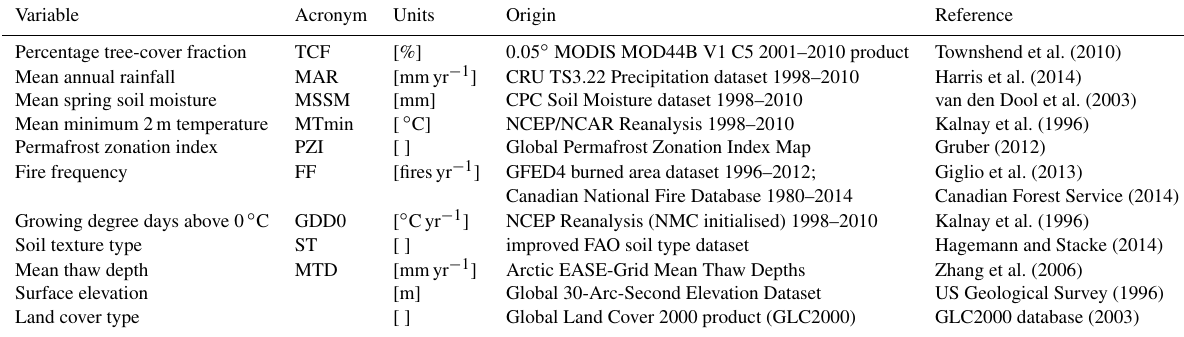
Table 1. Variables and datasets summary. Percentage tree-cover fraction indicates the proportion of land per grid cell covered by trees. Mean annual rainfall corresponds to the mean cumulative precipitation in millimetres over a year. Soil moisture is measured as water height equivalents in a 1 . 6m soil column. Minimum temperature refers to air temperature at 2m height. Permafrost zonation index shows the probability of a grid cell to have permafrost existing only in the most favourable conditions or nearly everywhere. Fire frequency is the averaged number of fire events per year. Growing degree days above 0 ◦ C correspond to the sum of the mean daily temperatures at 2m height above 0 ◦ C through a year, using 6h measurements. Soil texture describes the type of particles forming soil, ranging from sand to clay depending on the particle size. Mean thaw depth corresponds to millimetres of thawing soil during non-freezing days averaged per year. Surface elevation refers to the topographic altitude per grid cell in metres. Land cover type describes the type of vegetation and the density of the cover, independent of geo-climatic